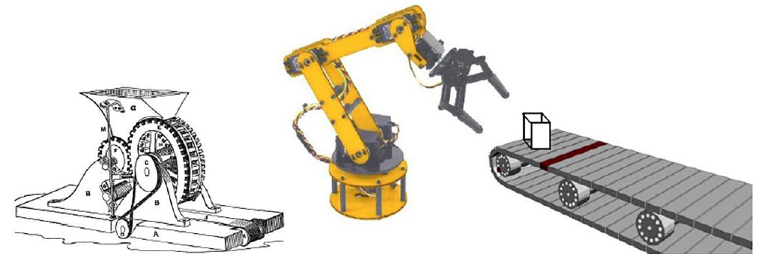
Fig 1. Schematic illustration of flexible manufacturing cell with single